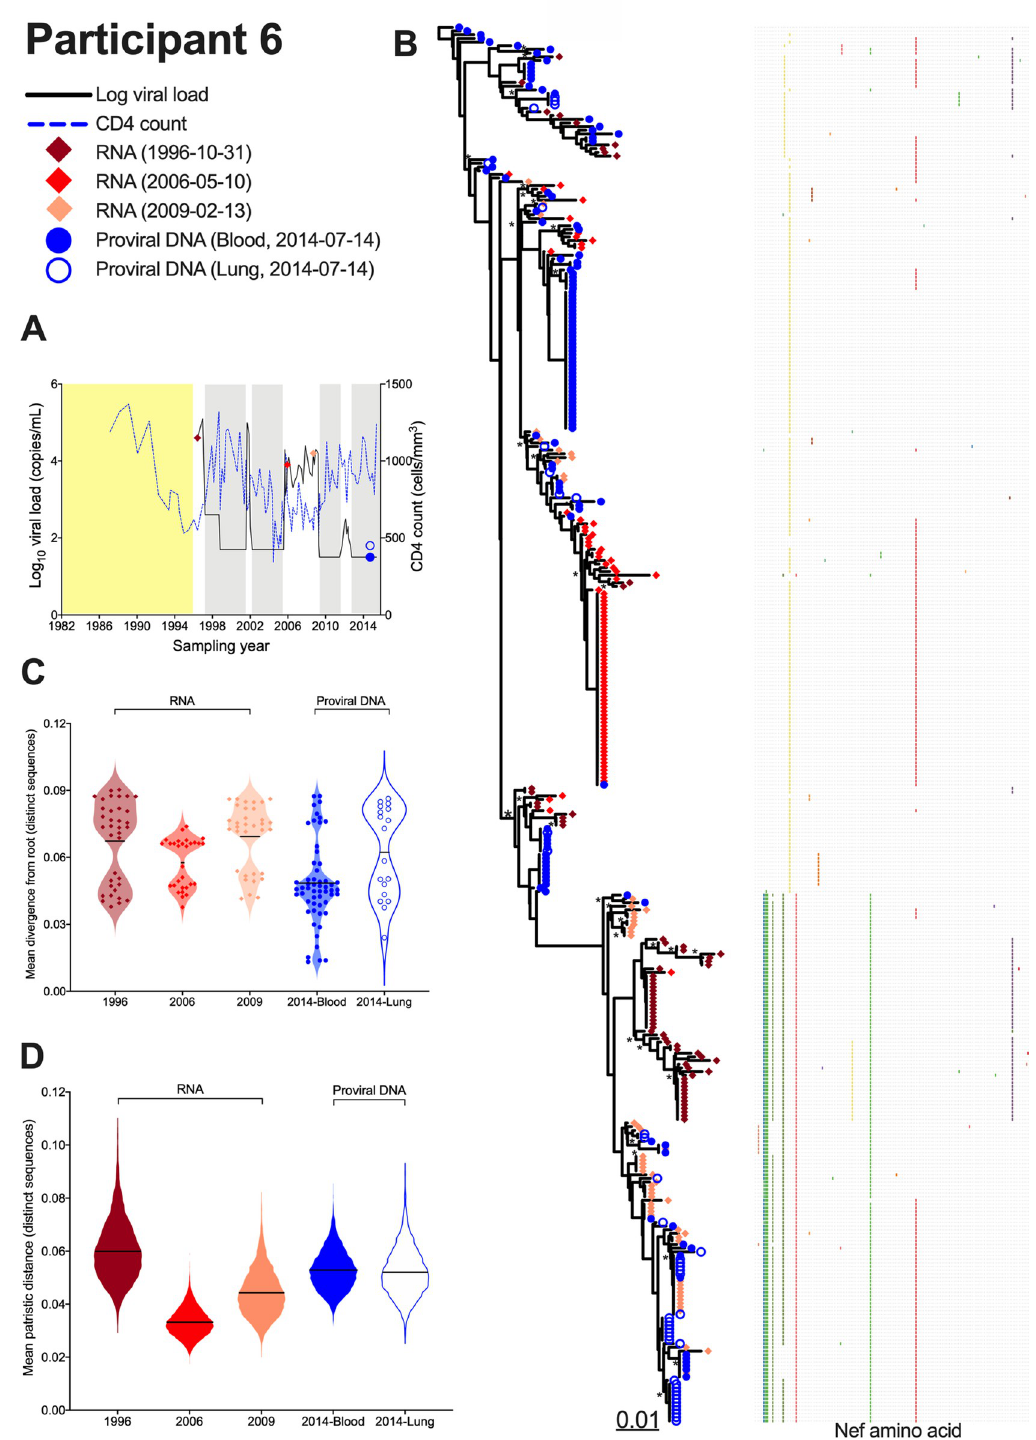
Fig 7. Interpreting proviral diversity in context of prior within-host HIV evolution: participant 6. (A) Plasma viral load (solid black line), CD4 + T-cell count (dashed blue line) and samples analyzed (colored diamonds and circles). Yellow shading denotes period following infection where clinical information is incomplete. Grey shading denotes periods of suppressive ART as per the HIV RNA pVL assay used at the time (until 1998, values < 400 copies/mL indicated undetectable viremia; later assays used a < 50 copies/mL cutoff) [91]. (B) Highest likelihood phylogeny derived from Bayesian inference, outgroup rooted. Scale